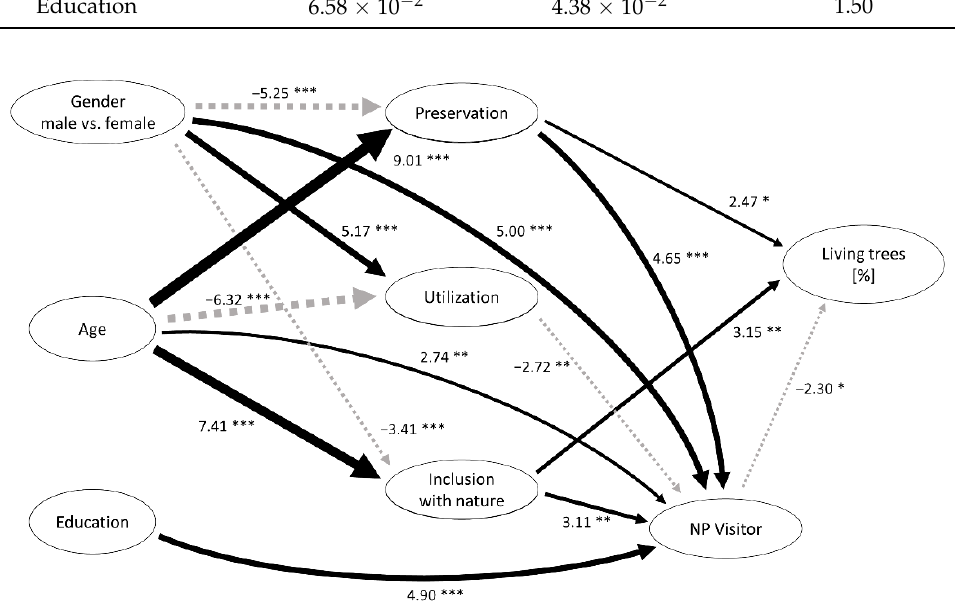
Figure 5. Structural equation model, with sociodemographic parameters on the left, preservation, utilization, and inclusion with nature in the center and previous visits of bark-beetle-affected national parks (yes/no) and the proportion of living trees on the right. Arrows are labeled with the corresponding z -values and significance levels (*** p < 0.001, ** 0.001 < p < 0.01, * 0.01 < p < 0.05). Arrow width corresponds to the z -values of the model (see Table 1 for coefficients). Black solid lines are for positive and grey dotted lines for negative effects. The figure shows only significant results.